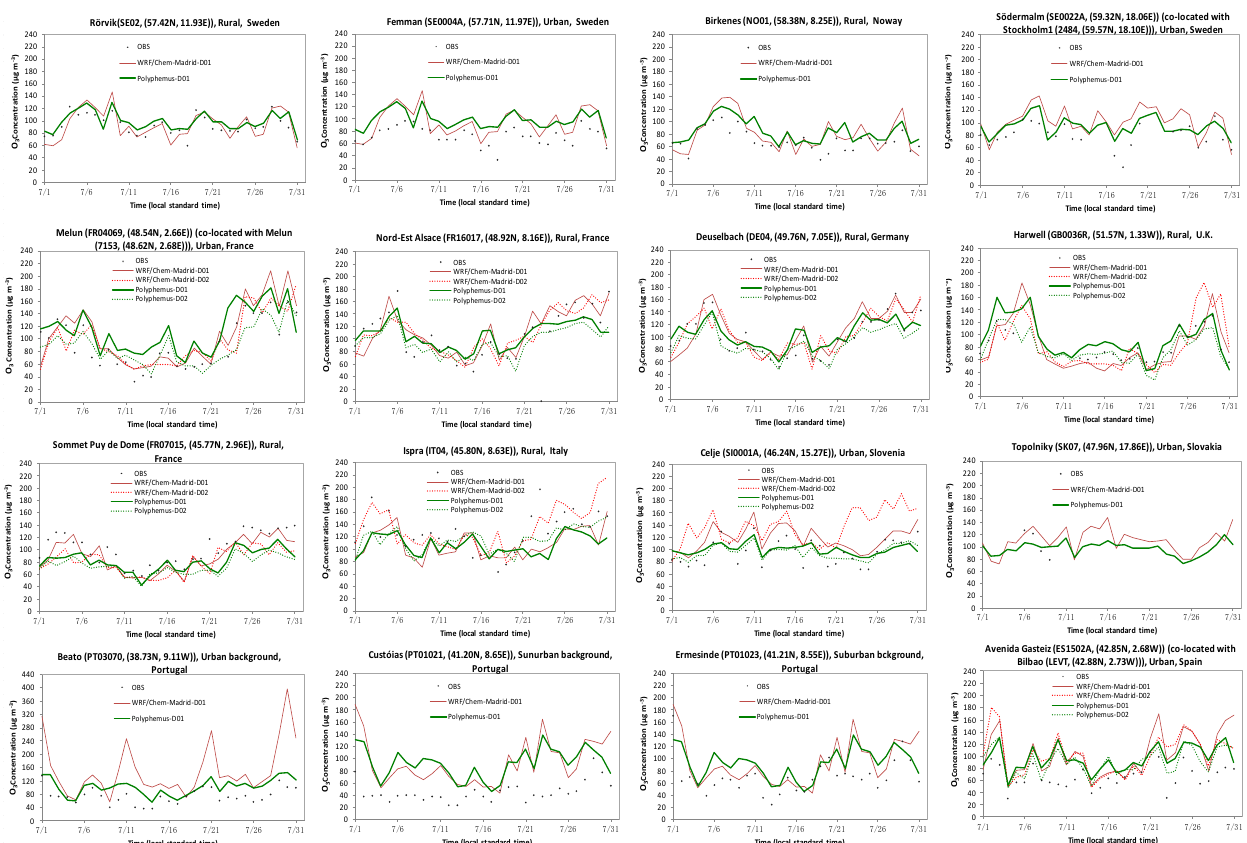
Figure 6. Simulated and observed concentrations of max 8-hr O 3 in July 2001 at selected sites over D01 and D02 in four latitude bands: 57-60 ºN, 48-52 ºN, 45-48 ºN, and 38-43 ºN (rows 1, 2, 3, and 4, respectively). Fig. 6. Simulated and observed concentrations of max 8h O 3 in July 2001 at selected sites over D01 and D02 in four latitude bands: 57–60 48–52 ◦ N, 45–48 ◦ N, and 38–43 ◦ N (rows 1, 2, 3, and 4,